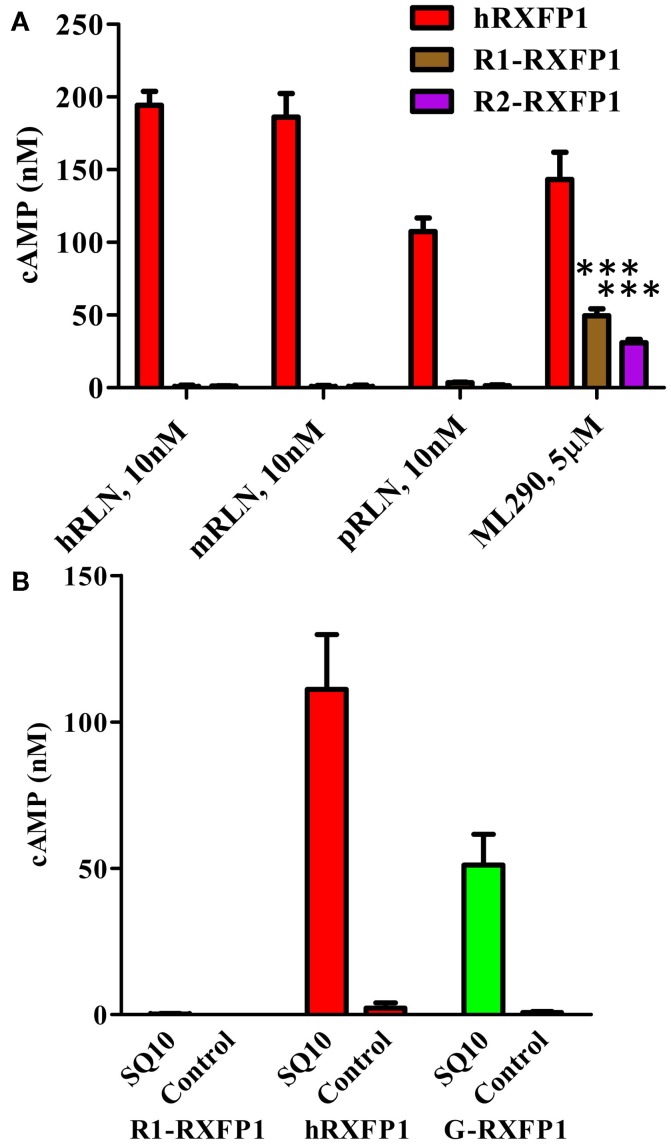
Activation of rabbit receptors by relaxin peptides from different species. (A) Activation of two rabbit receptor variants (R1- and R2-RXFP1) and hRXFP1with 10 nM of human (hRLN), mouse (mRLN), and porcine (pRLN) relaxin peptides, and by 5 μM of ML290. Treatments of rabbit RXFP1 are statistically significant compared to hRXFP1, ***p < 0.001. (B) Activation of rabbit (R1-), human (h), and guinea pig (G-) RXFP1s with rabbit relaxin SQ10. Conditioned media from HEK293T cells transfected with SQ10 and control empty vector was used for cell stimulation. cAMP activity is expressed as the percentage of 10 μM Forskolin stimulation for each type of cells. Data are expressed as mean ± SEM; each point represents triplicate measurements. The experiment was repeated at least three times. Treatment of R1-RXFP1 is statistically significant (p < 0.0001) compared to hRXFP1 or G-RXFP1.